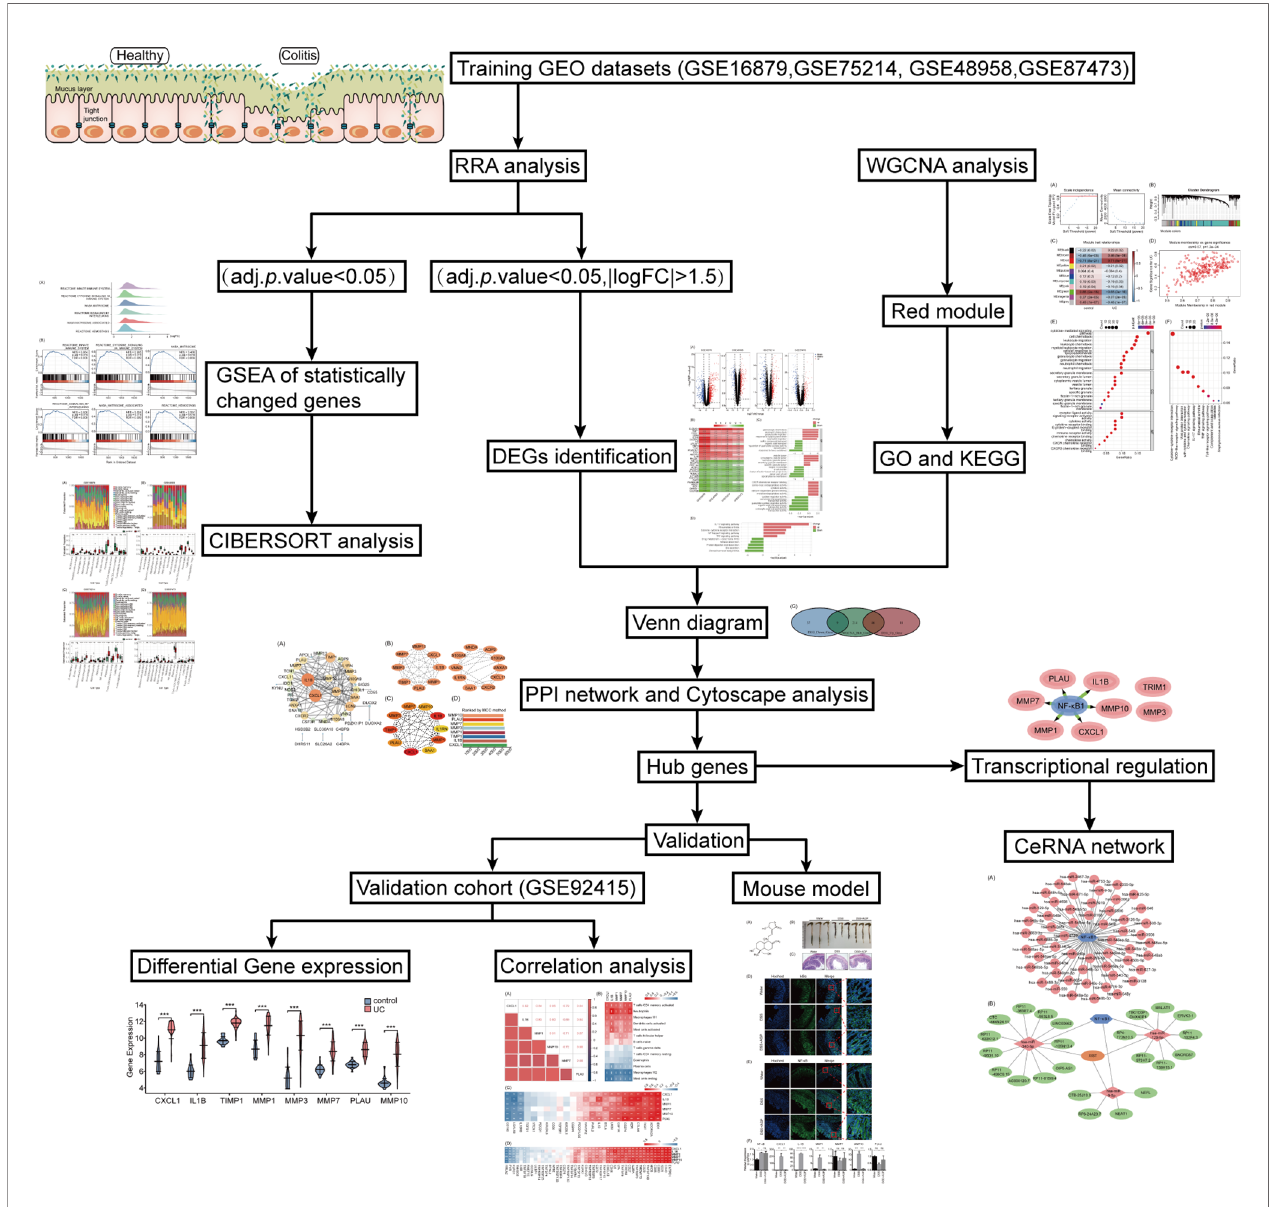
FIGURE 1 | Flowchart of the